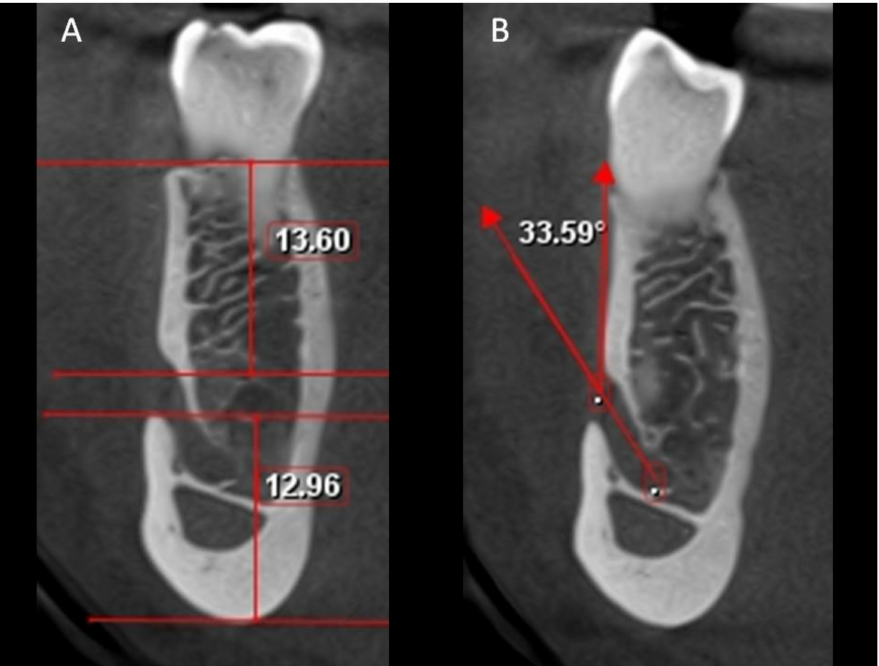
Figure 2. Coronal view showing the distance from the mental foramen to the upper and lower border of the mandible ( A ) and angulation between the mental canal and the buccal cortical bone superior to the mental foramen ( B